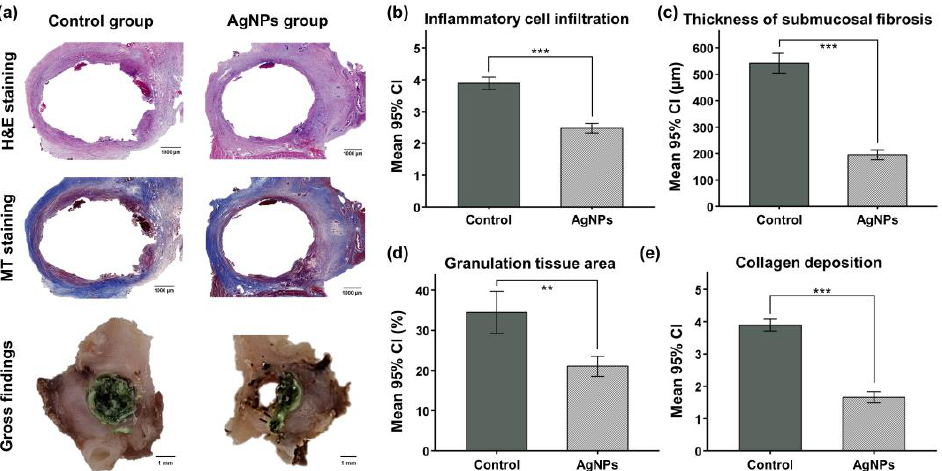
Figure 5. Gross and histological findings. ( a ) Representative images of gross and histologic findings revealed that the degree of tissue hyperplasia was higher in the control group than in the AgNPs group. ( b – e ) Histological results of the stented extrahepatic bile duct in the two groups. CI, confidence interval; ** p < 0.01, *** p <